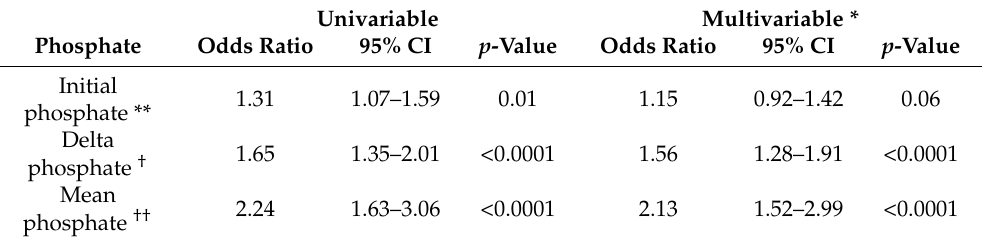
Table 3. Logistic regression analyses for phosphate categories in association with hospital mortality.